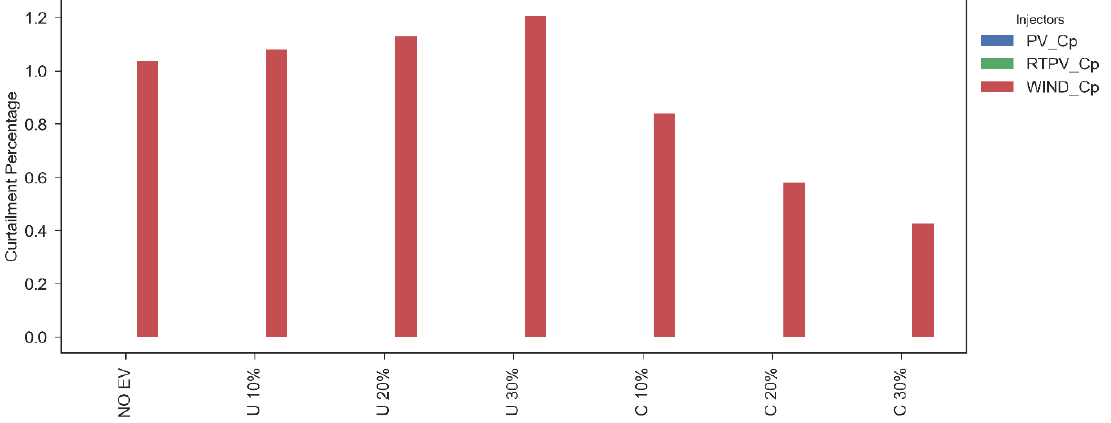
Figure 17. The percent curtailments during the peak weeks in July for all EV penetration scenarios and charging strategies.